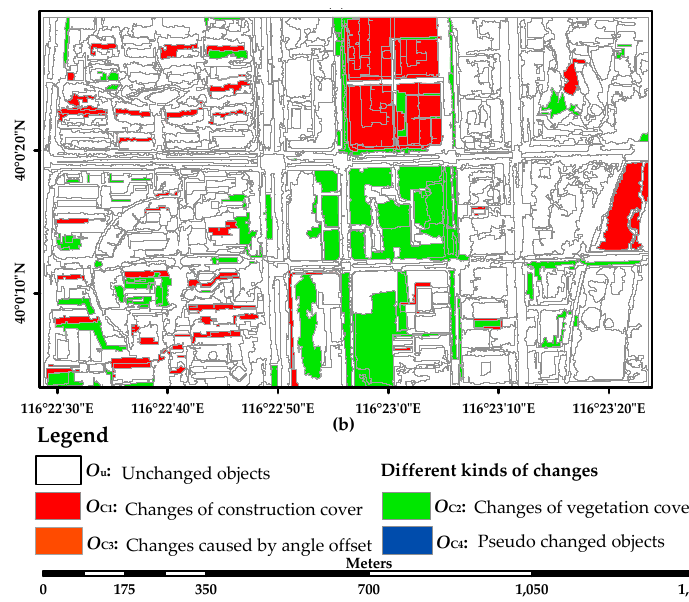
Figure 10. The OBCD result map obtained with ( a ) the proposed SAW-CVA approach and ( b ) the standard CVA approach.